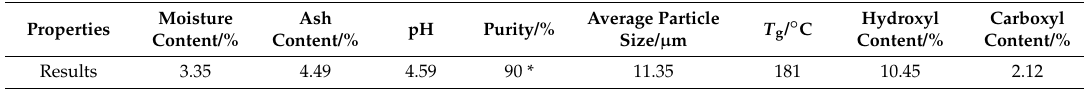
Table 1. Properties of the